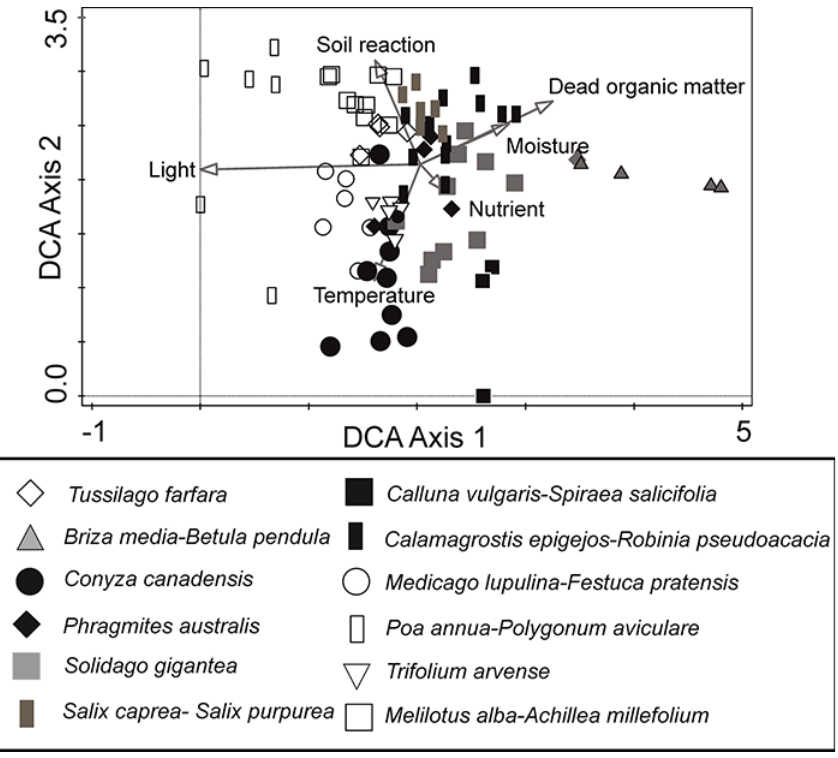
Fig. 2 Ordination diagram of the DCA analysis for the vegetation on the postmining “Ruda”